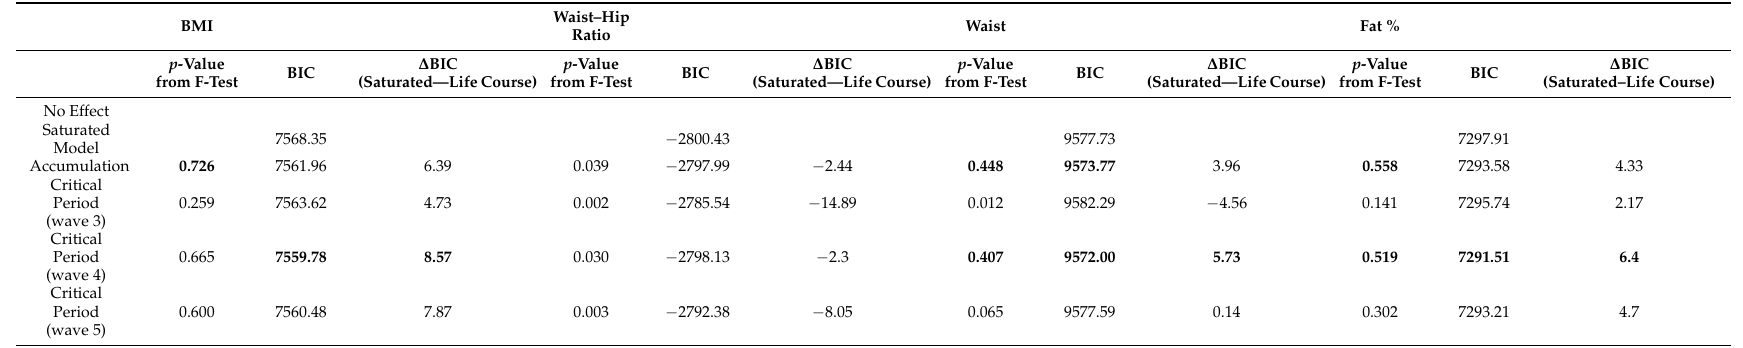
Numbers in bold indicate the best fitting model. Table 6. Adjusted mean differences (95% CI) in main study outcomes for the strongest-fitting life course model, adjusted for health behaviours (exercise, smoking, and consumption of sweets and